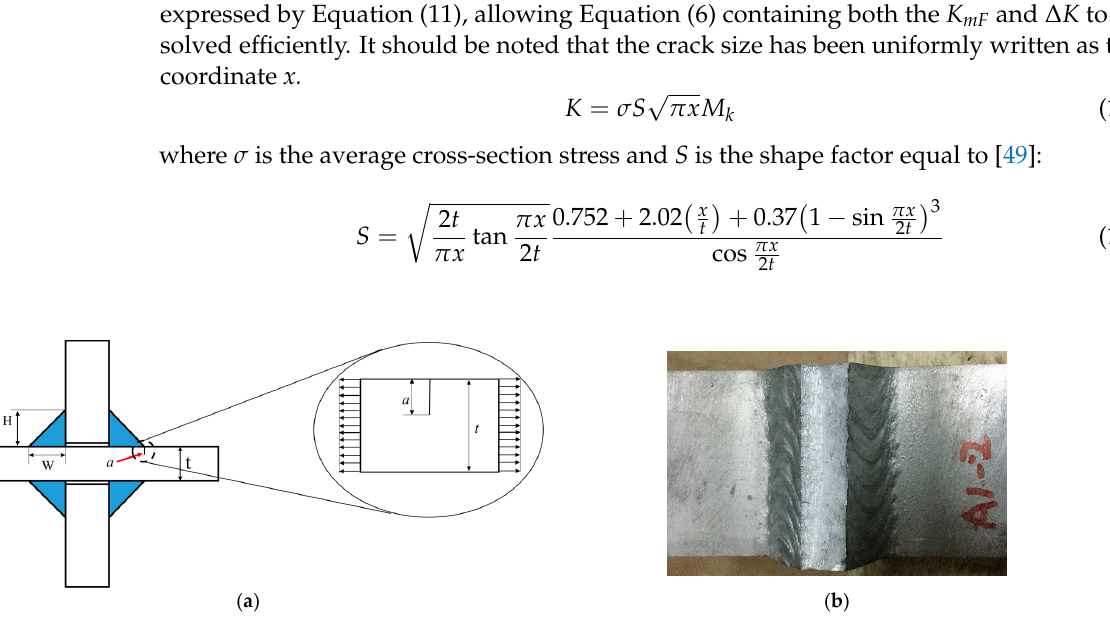
Figure 6. Weld toe cracks of the cruciform joint can be equivalent to a single-sided crack. ( a ) Illustration for crack at weld toe, ( b ) Fatigue fracture at weld toe.